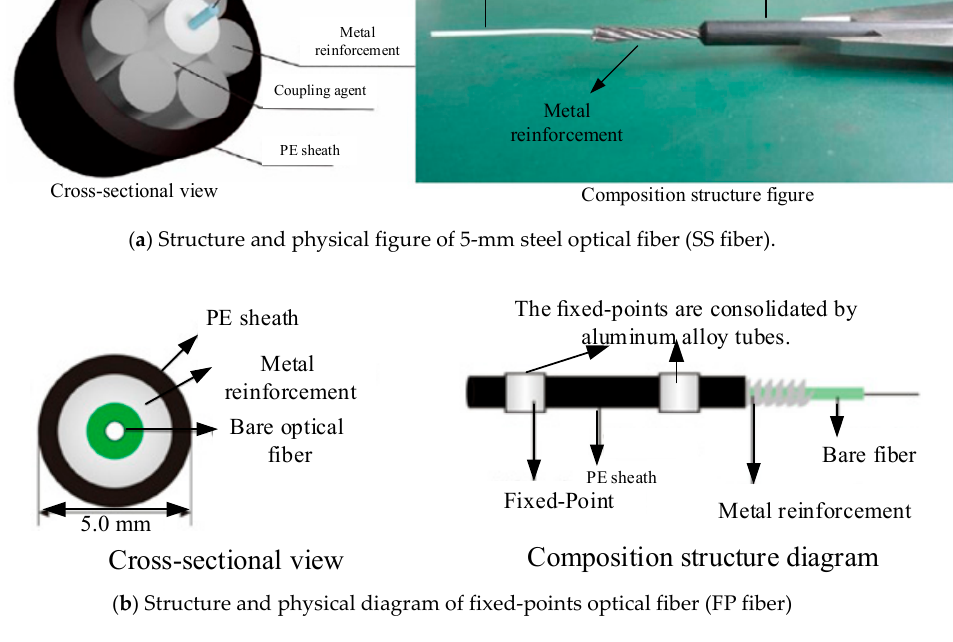
Figure 10. Cross-section and composition structure of the fibers. ( a ) SS fiber and ( b ) FP fiber.